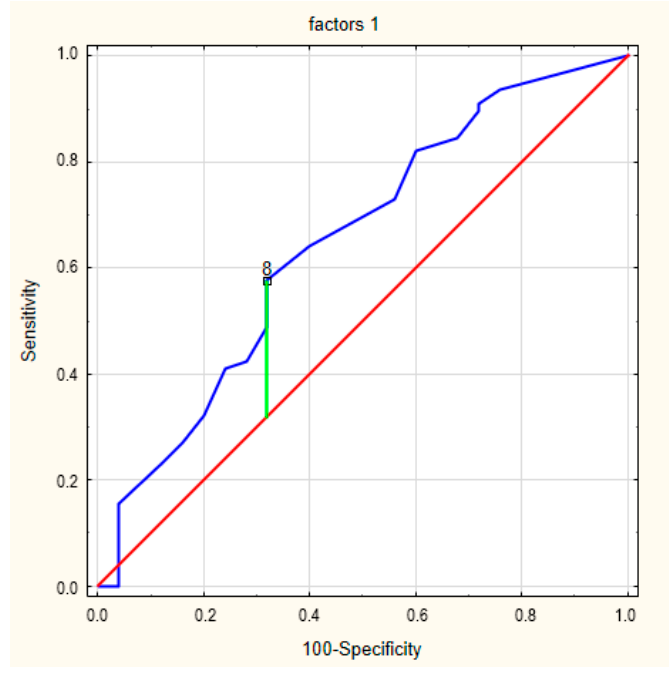
Figure 4. The ROC curves for factor 1 in frailty syndrome.